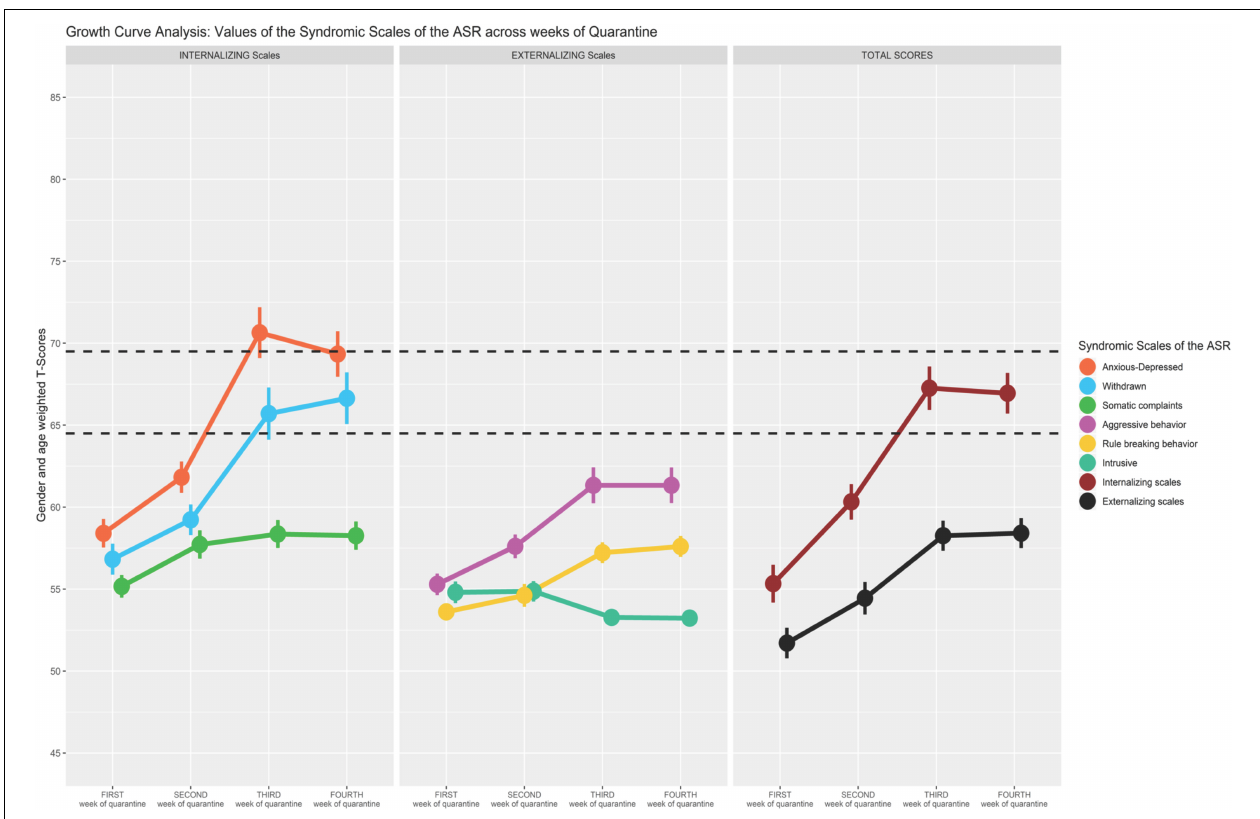
FIGURE 2 | Growth curve analysis: means and standard error of the Syndromic Scale across weeks of